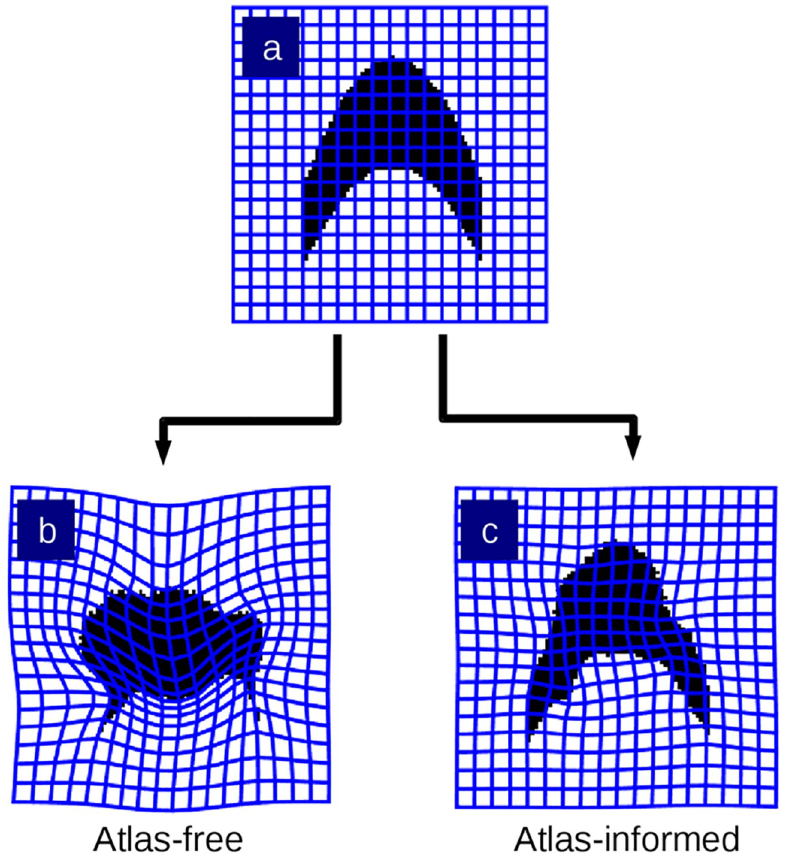
Fig 4. Comparison of resulting diffeomorphic transformation of atlas phantoms. The warped coordinate grids illustrate the difference in the mapping deformation from the atlas-free methods from (A) to histology stack target (B) versus the atlas-informed algorithm which produces